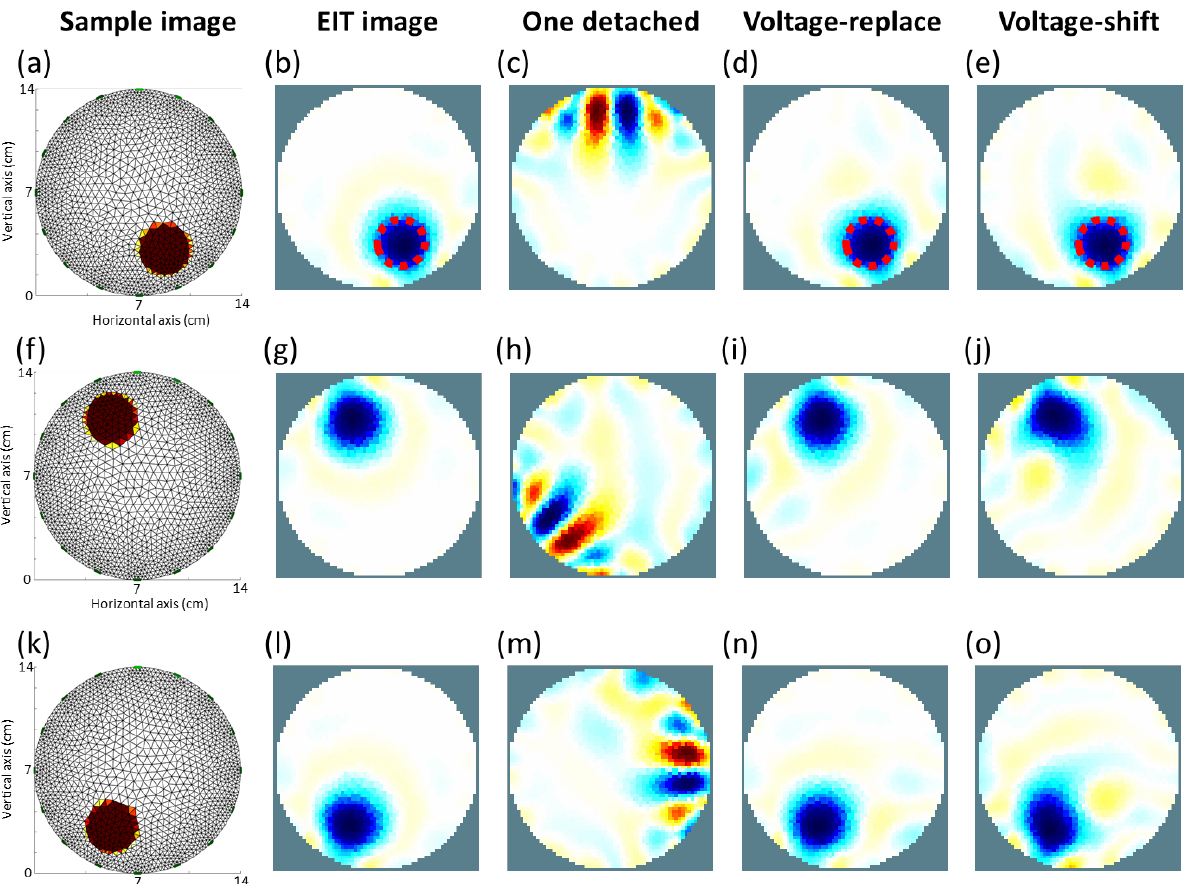
Figure 10. Simulated electrical impedance tomography (EIT) images. ( a ) Sample image with circular inclusion at (x = 2.5 cm, y = −5.5 cm). ( b ) EIT image of ( a ). ( c ) EIT image of ( a ) with first electrode detached. ( d ) Image reconstruction for ( c ) using the voltage-replace method. ( e ) Image reconstruction for ( c ) using the voltage-shift method. ( f ) Sample image with circular inclusion at (x = −2.5 cm, y = 5.5 cm). ( g ) EIT image of ( f ). ( h ) EIT image of ( f ) with seventh electrode detached. ( i ) Image reconstruction for ( h ) using the voltage-replace method. ( j ) Image reconstruction ( h ) using the voltage-shift method. ( k ) Sample image with circular inclusion at (x = −2.5 cm, y = −5.5 cm). ( l ) EIT image of ( k ). ( m ) EIT image of ( k ) with the fifth electrode detached. ( n ) Image reconstruction for ( m ) using the voltage-replace method. ( o ) Image reconstruction for ( m ) using the voltage-shift method.